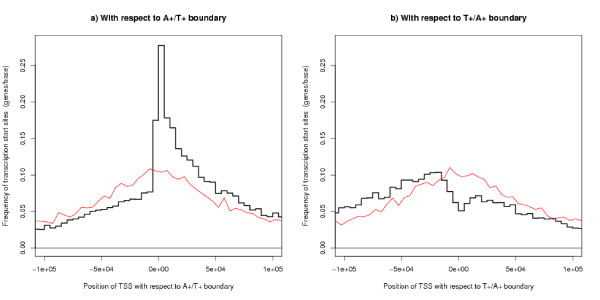
Position of TSS with respect to the segment boundaries. The bold black line shows results for real TSSs and the faint red line is a control plot for randomly chosen positions. (a) shows the A+/T+ boundary and (b) shows T+/A+ boundary. TSSs of genes cluster near the A+/T+ boundary and have a tendency to occur downstream of this boundary, but avoid the T+/A+ boundary. The converse applies to the TES – see Figure 9.